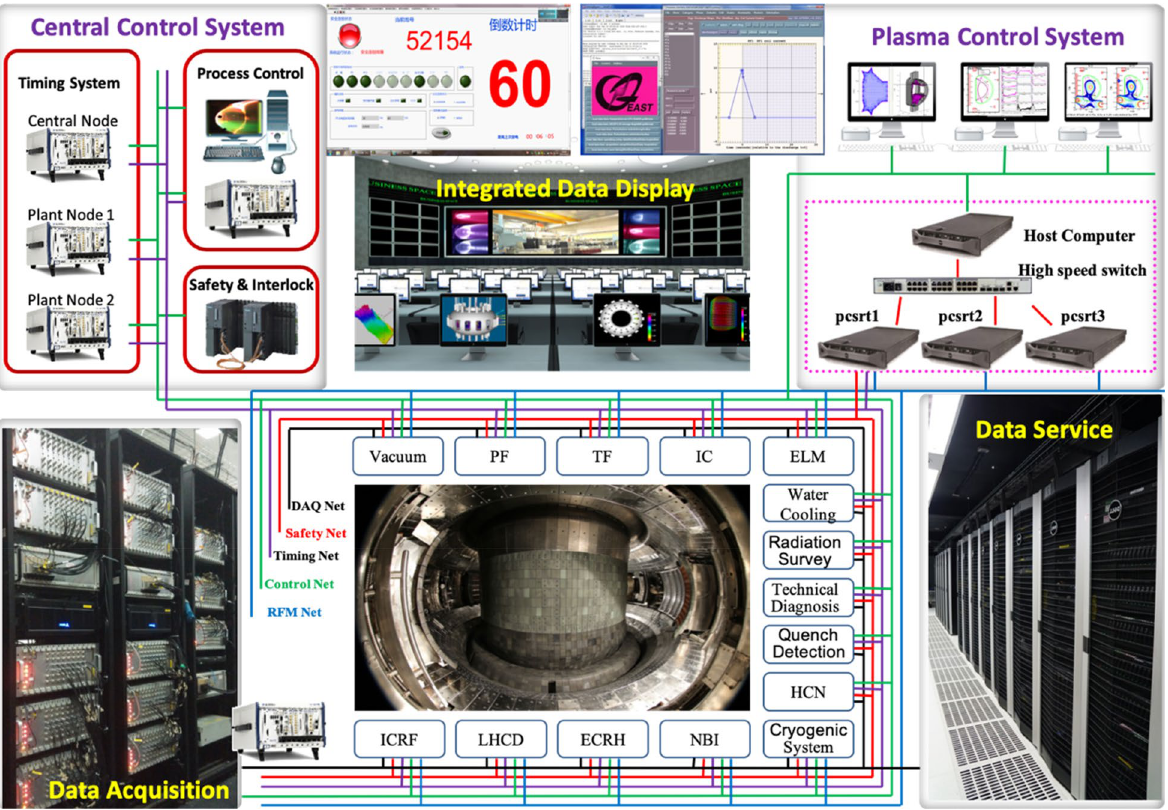
Fig. 7 Block diagram of EAST CODAC and plasma control